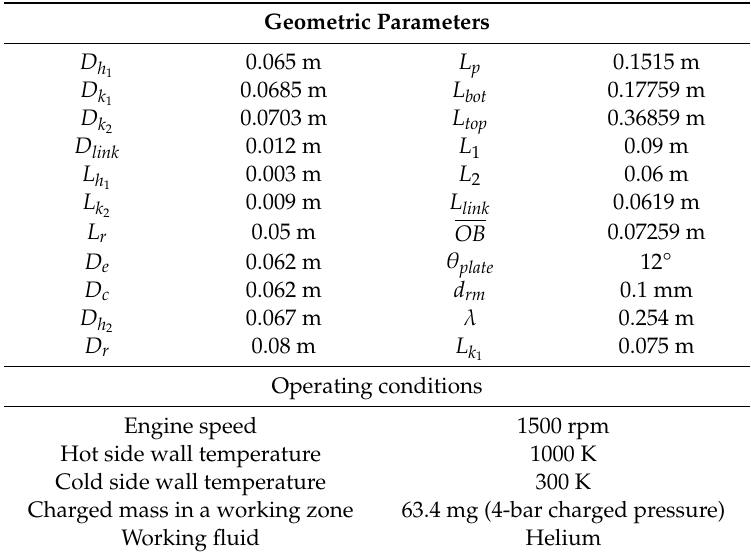
Table 2. Specifications of the test